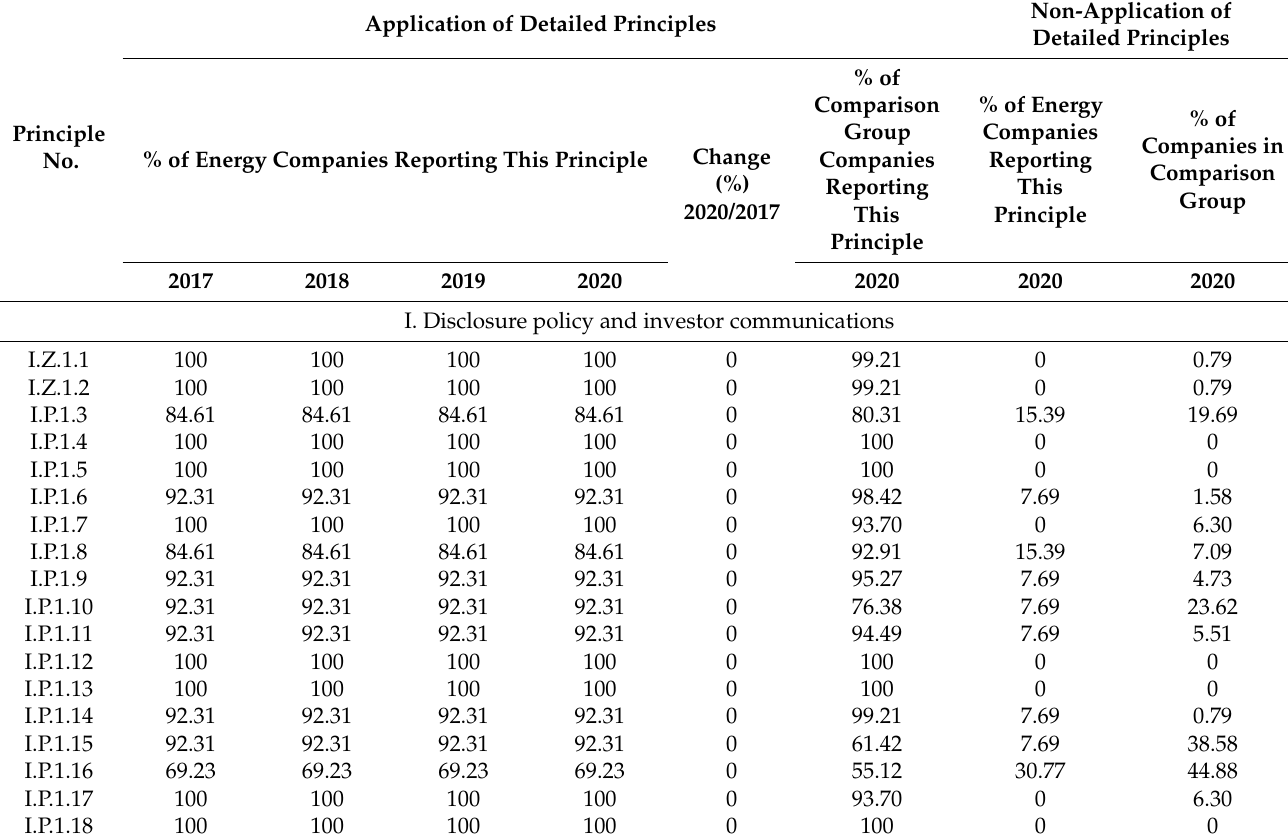
Table 4. Percentage of companies reporting in line with the detailed principles of BPs for